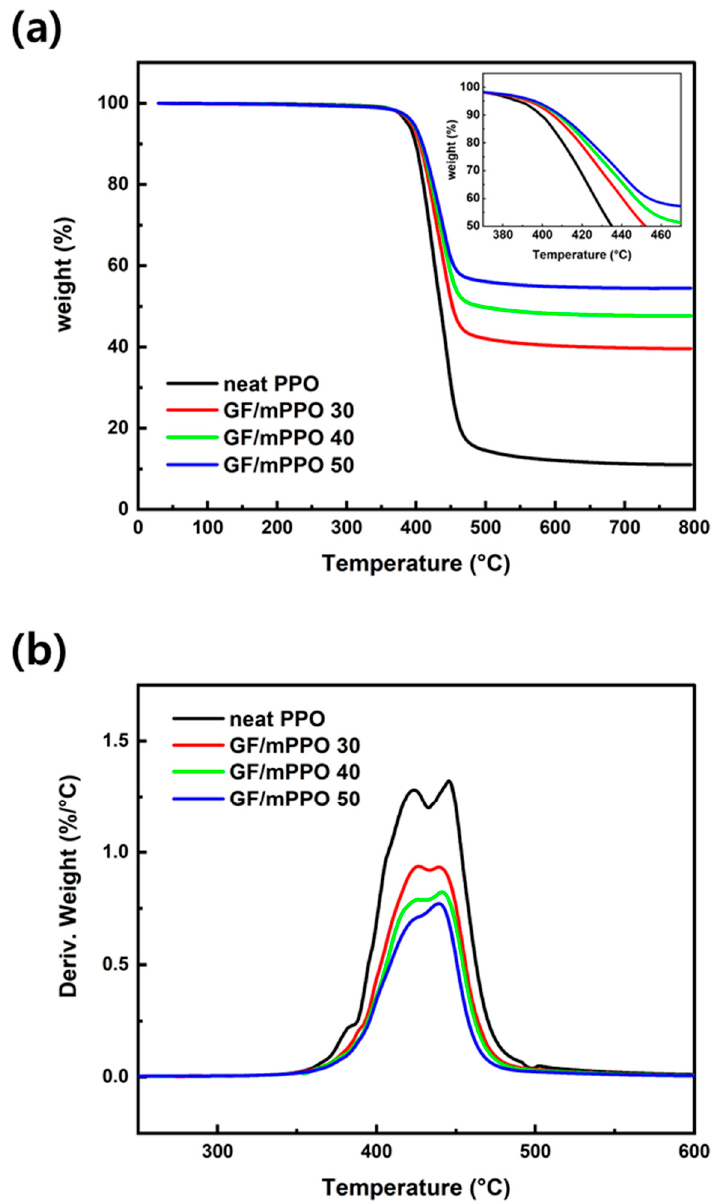
Figure 8. Typical TGA results of neat mPPO and GF/mPPO composites; ( a ) weight loss curves, and ( b ) derivative thermogravimetric curves. ( b ) derivative thermogravimetric